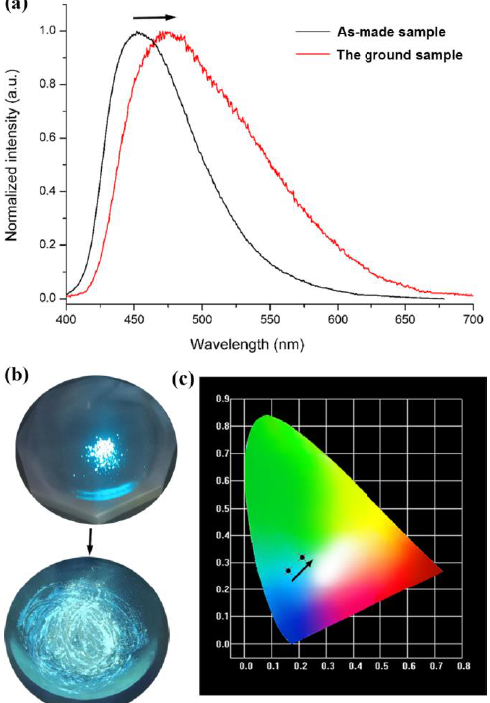
Figure 2. ( a ) The FL spectra of the as-made and ground samples of Sr 2 (tcbpe) measured at room temperature. ( b ) Photographic image of the luminescent changes of Sr 2 (tcbpe) under 365 nm light before and after grinding. ( c ) Photograph of the CIE chromaticity diagram for Sr 2 (tcbpe) before and after grinding.